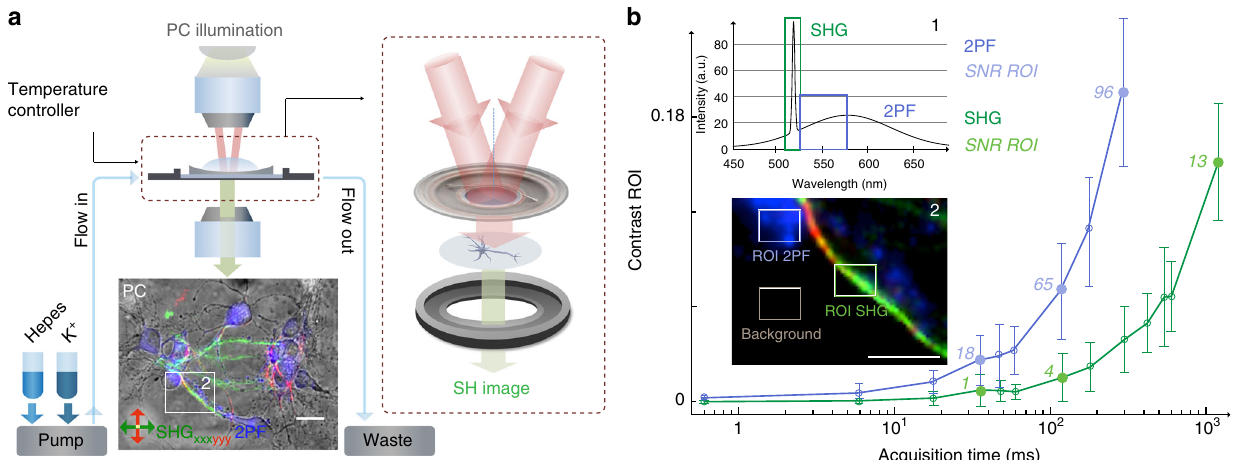
Fig. 1 Protocol and imaging con fi guration with second harmonic throughput for neuroimaging. a Imaging con fi guration and protocol with a composite image of 17 days in vitro (DIV) primary cultured cortical mouse neurons. The neurons are provided with a constant fl ow of solution via a peristaltic perfusion system and SH imaging is done in a wide- fi eld double beam transmission geometry. The composite image, is composed of a phase contrast (PC), label-free SH (in green and red) and 2PF, and the scale bar is 20 µ m. The double head red and green arrows in the image represent the orientation of the respective incoming and analyzed polarization for SH signal. The emitted spectrum is composed of a second harmonic (SH) component and an endogenous two- photon fl uorescence (2PF) contribution, as shown in inset 1 in panel b . b Michaelson contrast with signal to noise ratio (SNR) values in italic, calculated from the region of interests (ROIs) indicated by the rectangles in the zoomed inset 2 (scale bar, 10 µ m) for the SH and 2PF images. Error bars were calculated from the standard deviation of the intensity values from the respective ROIs and drawn as vertical error bar at each data point. The insets show, 1 the emission spectra from a neuron with the SHG response (narrow peak, being at the exact double frequency of the 1030 nm fundamental) and the 2PEF response (a broad band at lower frequencies than the SH frequency) clearly visible, and 2 the zoomed inset from the image in panel a used to calculate the contrasts and